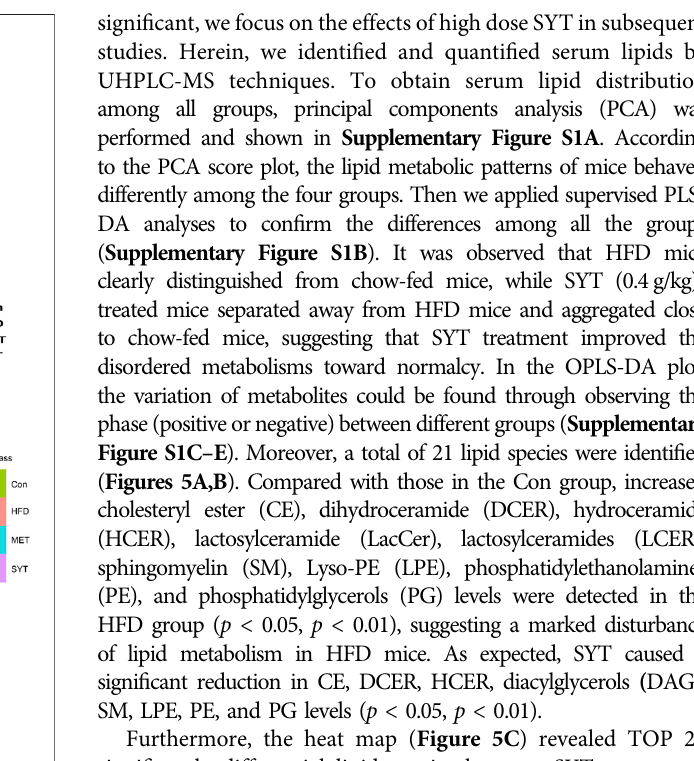
Frontiers in Pharmacology |